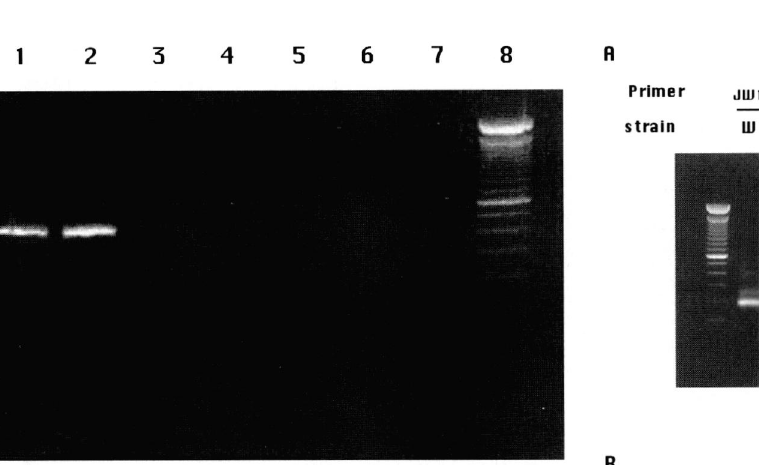
Fig. 2. - PCR detection of GLOFR-C4 gene in two groups of Giardia intestinalis, other protozoa and bacteria. Using two primers, C4-F and C4-R based on GLORF-C4 sequence of GS, GLORF-C4 DNA of 443 bps were amplified from the follo­ wing genomic DNAs; lane 1, WB (assemblage A Giardia intesti­ nalis); lane 2, GS (assemblage B Giardia intestinalis); lane 3, Acan- thamoeba cubertsoni; lane 4. Entamoeba histolytica; lane 5. Toxoplasma gondii; lane 6, Escherichia